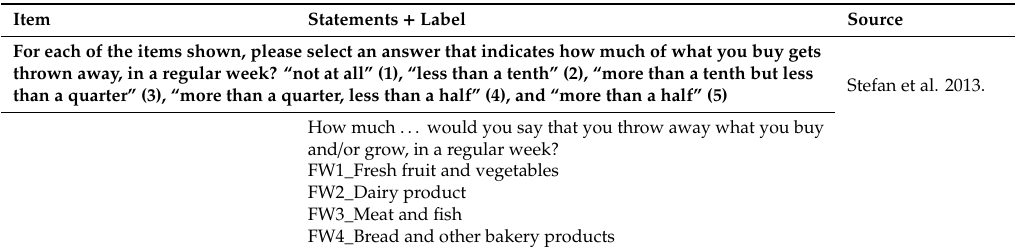
Table A4. Reported amount of food waste.